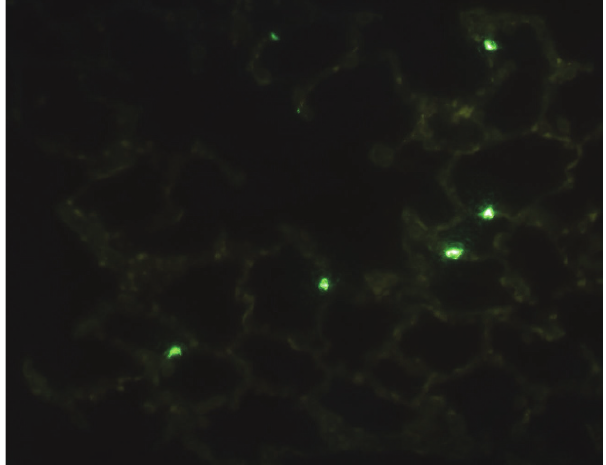
Figure 6 - Immunofluorescence microscopy (TUNEL) imaging for cell death analysis. Fluorescent-labeled cells (green) correspond to tissue death by